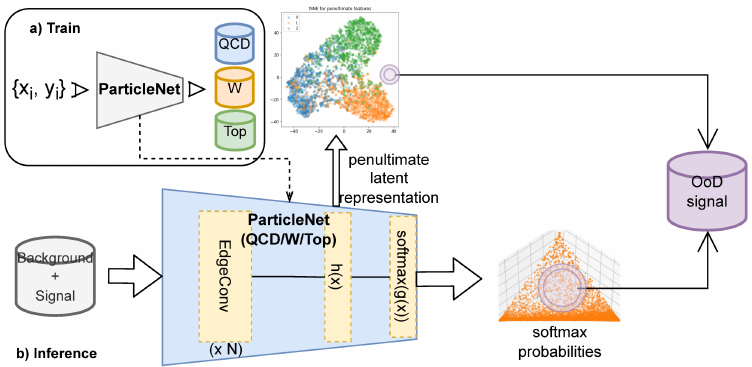
Figure 1 . The schematic of neural classifier based anti-QCD jet tagging. The workflow consists of two steps. In the train step (a), we choose the in-distribution classes and the feature extractor . In the inference step (b), we design post hoc anomaly scoring functions operating on the trained classifier model for signal